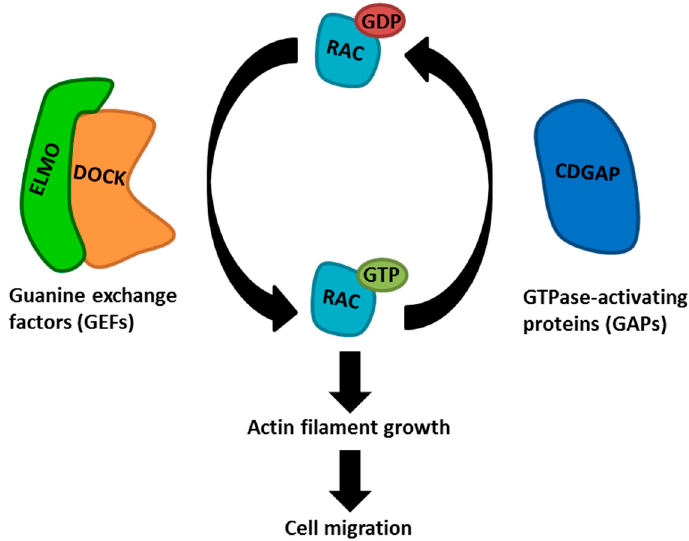
Figure 1. Schematic showing how the ELMO proteins are involved in cell migration. The ELMO proteins function as scaffolds regulating the spatiotemporal localization and activity DOCK guanine exchange factors (GEFs), which promote the active GTP-bound form of RAC proteins. GTPase activating proteins (GAPs) may return RAC to its inactive GDP-bound form. Activated RAC proteins promote actin filament growth, which is required for cell migration.